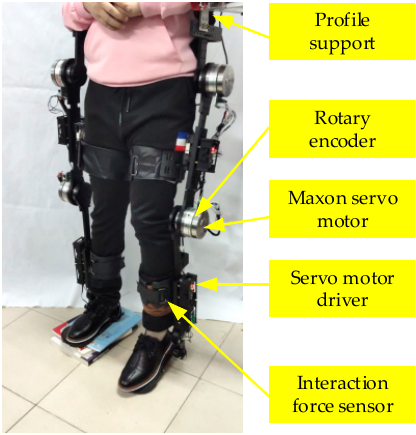
Figure 7. The LLRE robot prototype worn by a healthy subject.